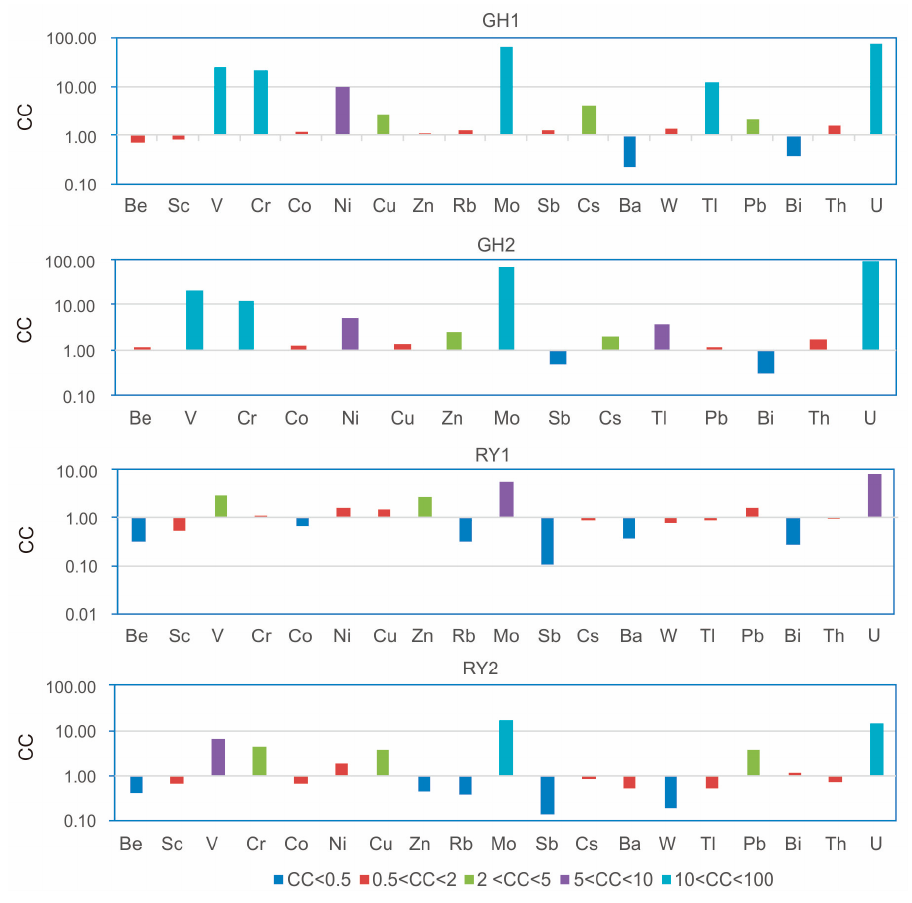
Figure 4. Concentration coefficient (CC) values for trace elements in the Ganhe and Rongyang coals.